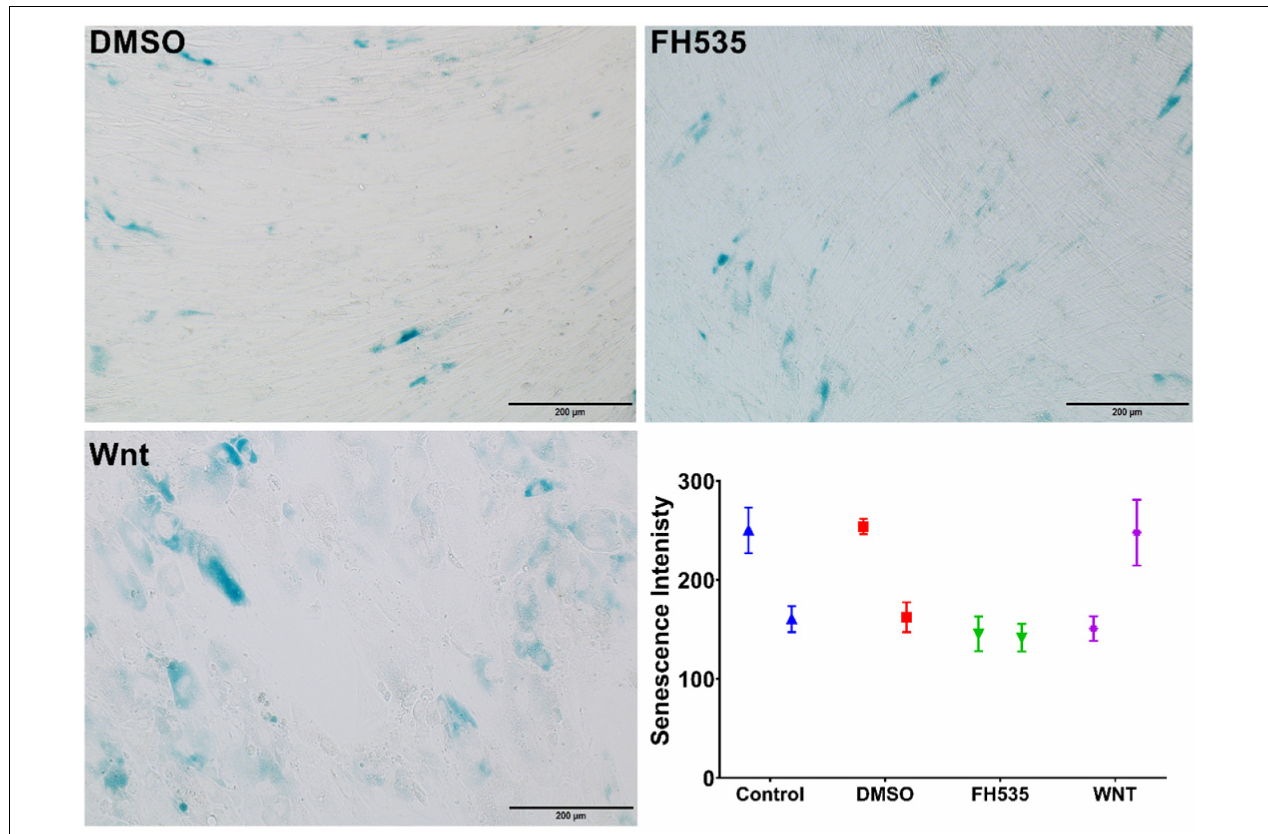
FIGURE 12 | Assessment of senescence using β -galactosidase. Healthy fibroblasts treated with DMSO, Wnt agonist, and inhibitor (FH535) then senescence signal were measured using beta-galactosidase staining kit.